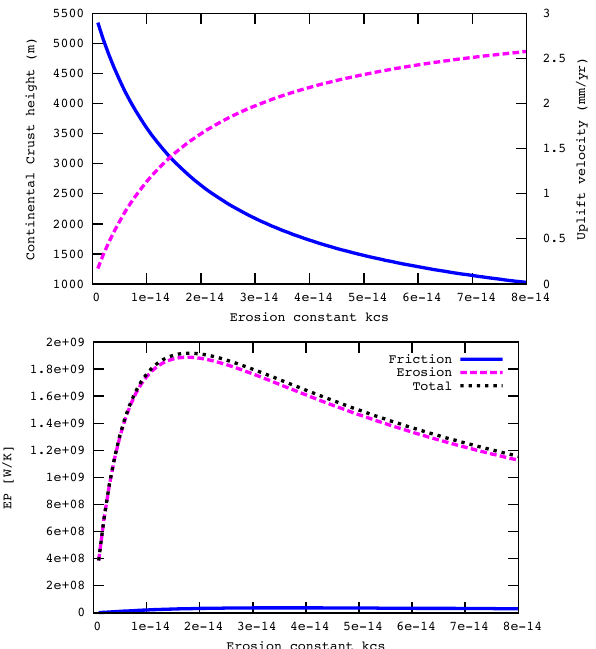
Fig. 10. Top plot: continental crust height plotted with solid line (units on left horizontal axis) and uplift velocity plotted with dashed line (units left horizontal axis) with varying values for erosion con- stant k cs . Increasing k cs decreases continental crust height and in- creases uplift velocity. Bottom plot: entropy production by erosion as a function of erosion rate, k cs . Entropy produced by friction plot- ted with a solid line, entropy produced by erosion plotted by a wide dashed line and total entropy production with a narrow dashed line.